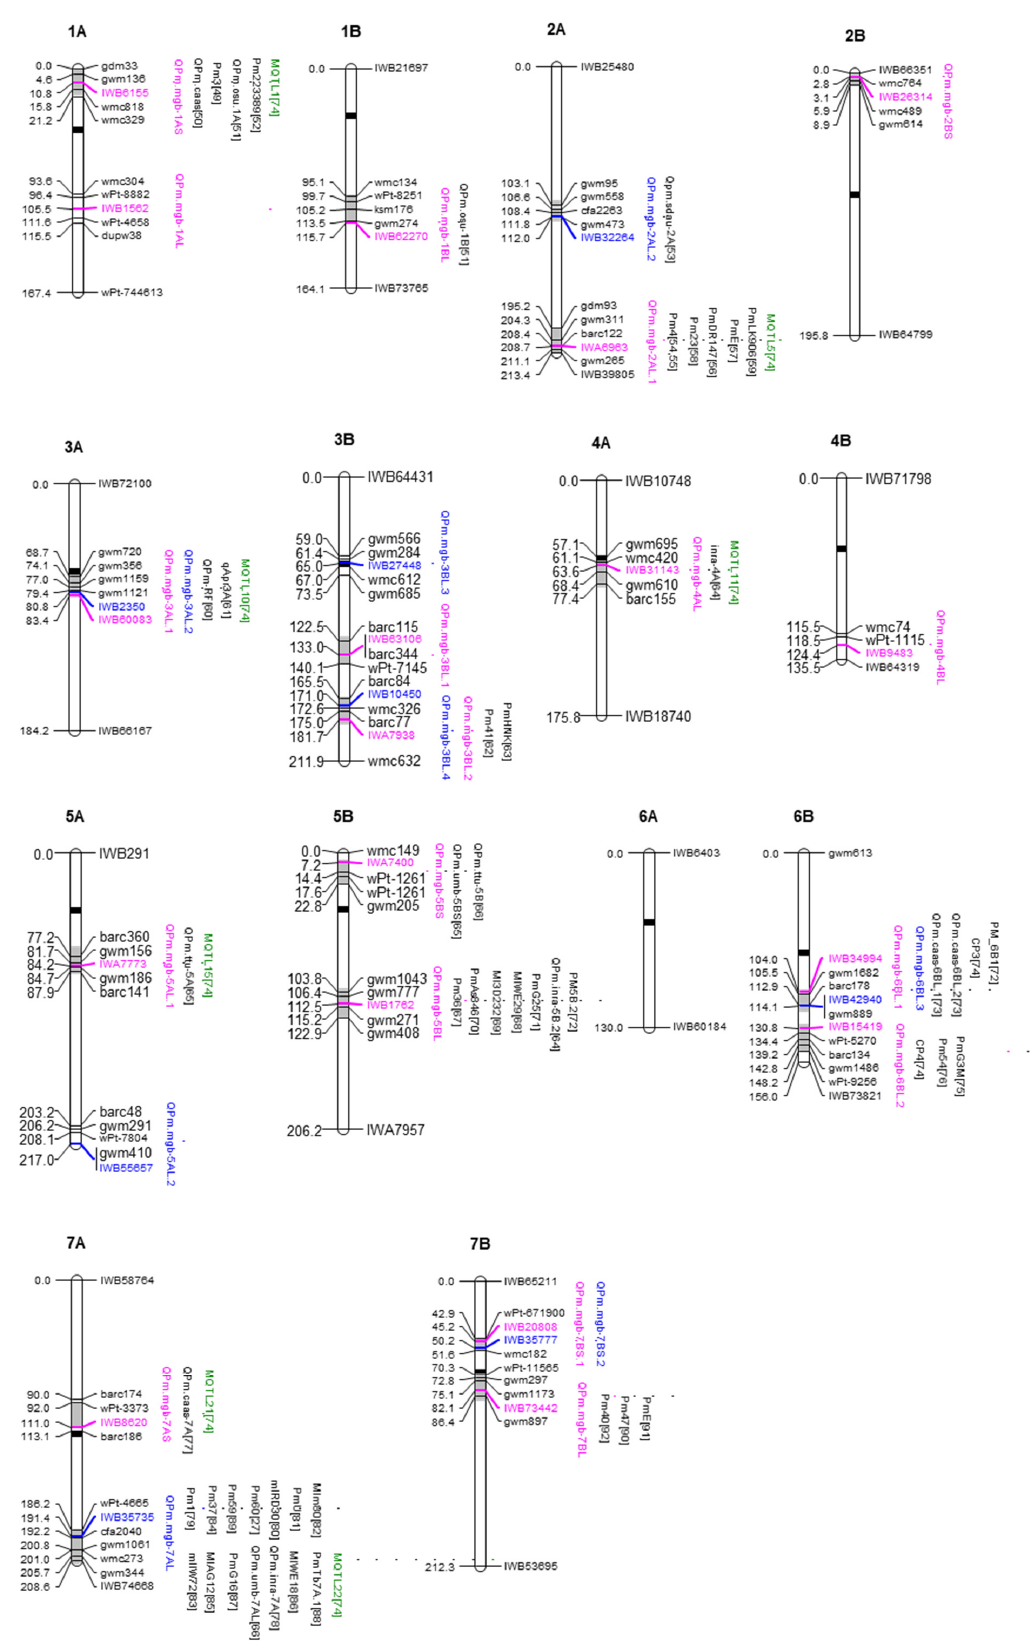
Figure2. Chromosomallocationonthedurumwheatconsensusmap[42]ofsignificantQTLforpowdery mildew resistance detected in the current study in relation to previously mapped QTL.